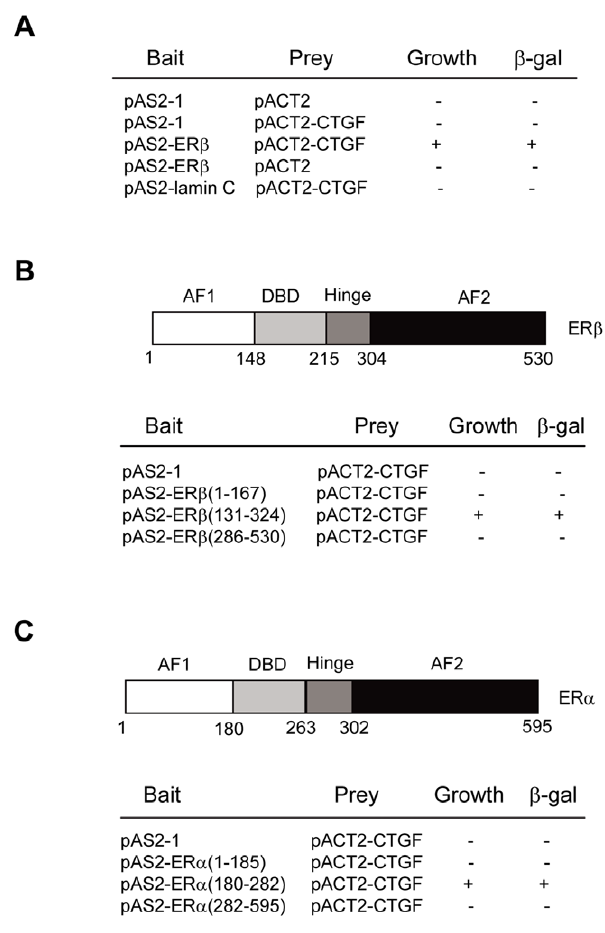
Figure 1. Identification and characterization of the CTGF-ER interaction in yeast cells. (A) Identification of CTGF as an ER b - interacting protein by the yeast two-hybrid system. Yeast CG1945 cells were transformed with the indicated plasmids (bait and prey) and grown on SD/-Trp-Leu and SD/-Trp-Leu-His. Colonies grown on SD/-Trp- Leu or SD/-Trp-Leu-His were tested for b -galactosidase activity (LacZ). Positive interaction is indicative of His- (growth) and LacZ- ( b -gal) positive colonies. (B) Mapping of the CTGF interaction region in ER b . CG1945 cells were transformed with the indicated constructs and analyzed as in (A). Schematic diagram of the ER b protein is shown at the top. (C) Mapping of the CTGF interaction region in ER a . CG1945 cells were transformed with the indicated plasmids and analyzed as in (A). Schematic diagram of the ER a protein is shown at the top.